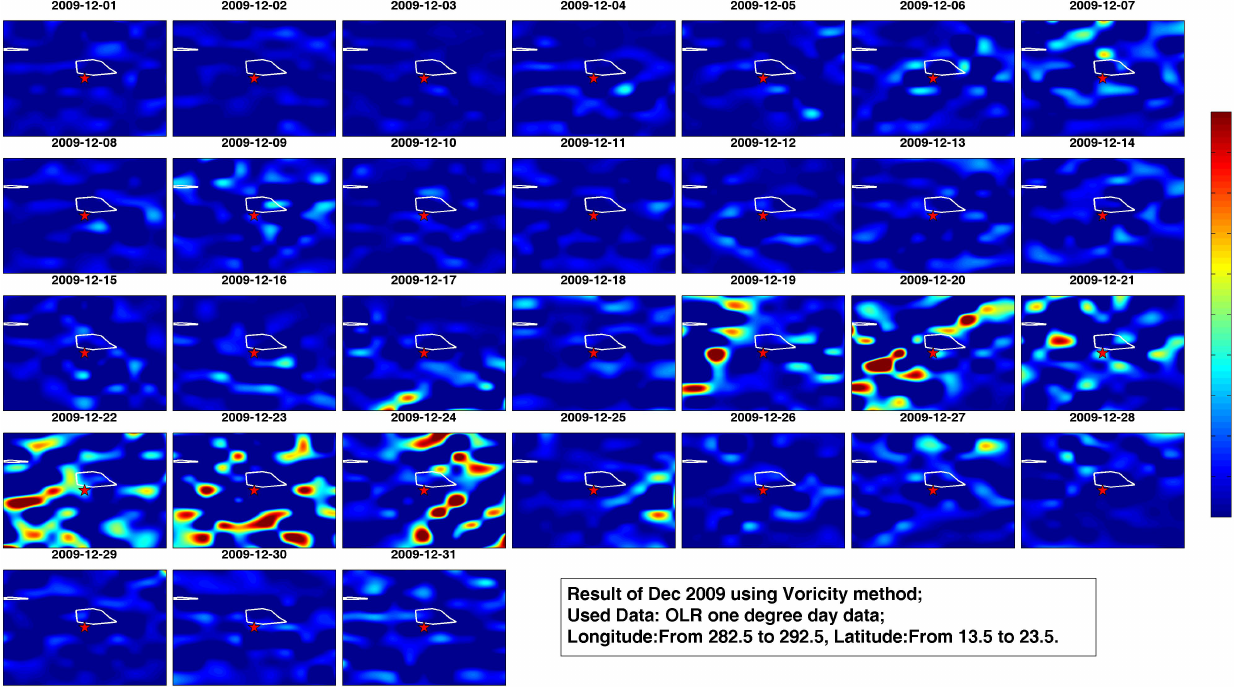
Fig. 9. Eddy field OLR (day data) curves of December 2009, for Haiti earthquake, epicenter is marked with red star, tectonic plate boundaries with white